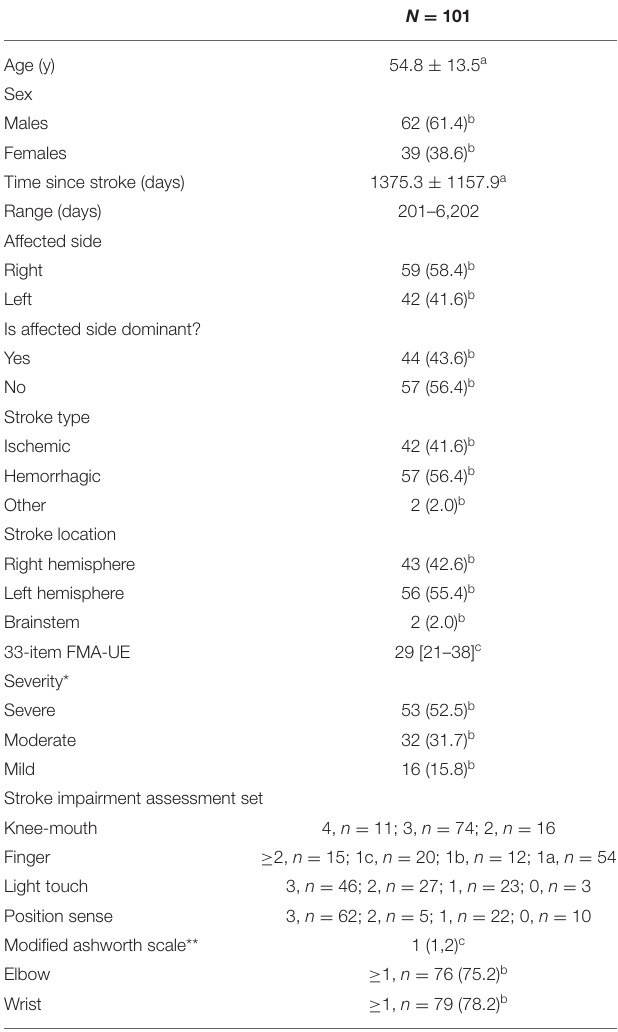
TABLE 1 | Demographic characteristics of the